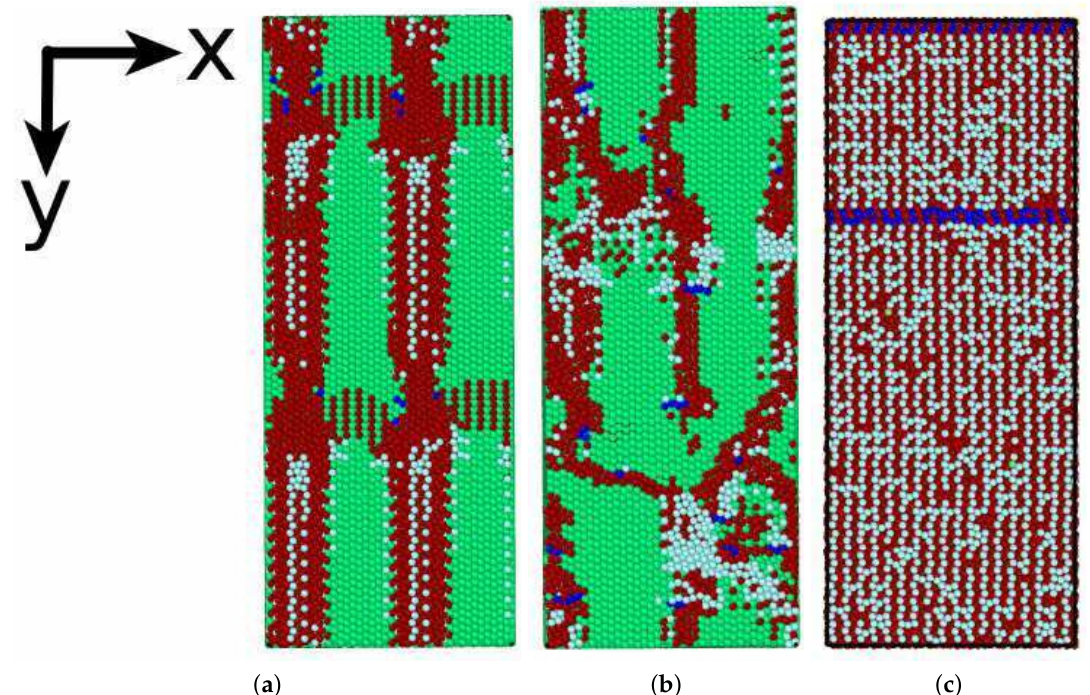
Figure 2. Top view—from the cementite side—of the Bagaryatsky interface: ( a ) after the first conjugate-gradient minimization; ( b ) after the second conjugate-gradient minimization; and ( c ) after the phase transition, at 1104 K (cf. Figure 6d). Only the Fe atoms on the iron side of the interface are shown. They are colored by their local lattice structure as determined by CNA: bcc (green); fcc (dark blue); hcp (light blue); and unidentified (red).